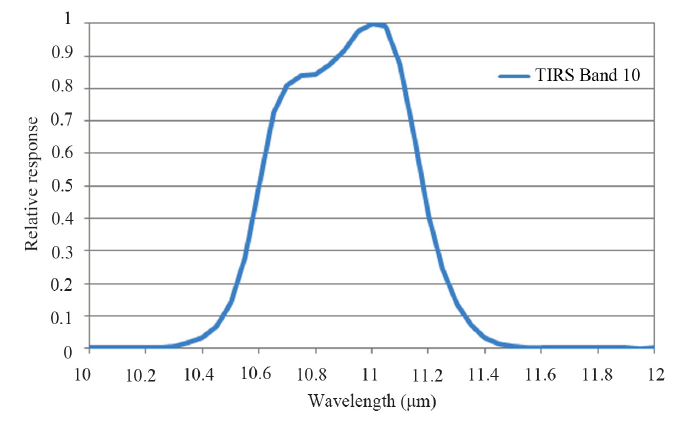
Figure 1. Spectral response function of Landsat 8 TIRS Band